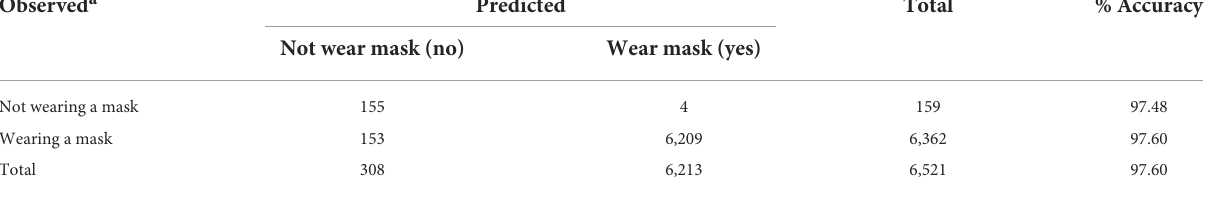
TABLE 3 Classification